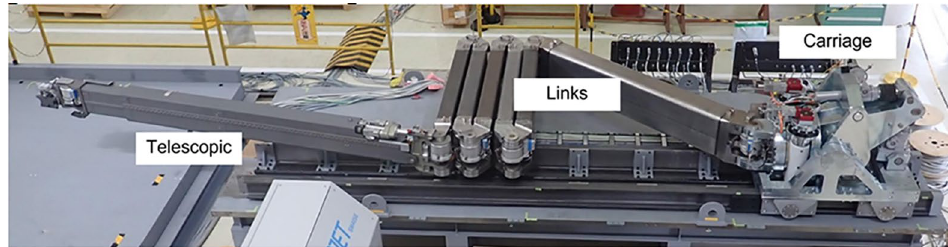
Fig. 1 Structure of the prototype “Veolia-MHI Arm” [1]